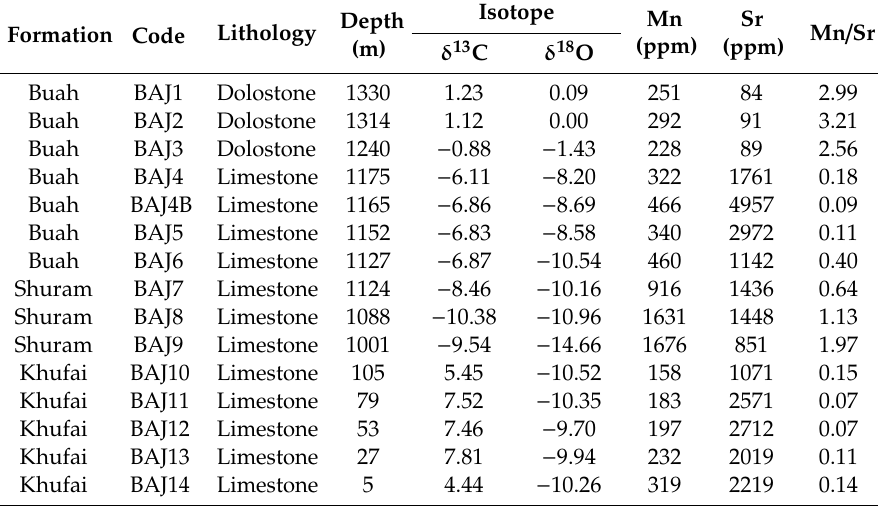
Table 2. Reference composite δ 13 C isotope, δ 18 O isotope, Mn and Sr data of the Huqf Group in Jabal